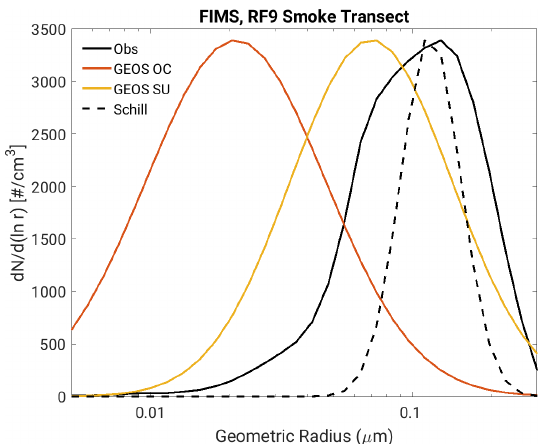
Figure 14. The observed dry aerosol size distribution from FIMS for the flight segment from RF9 as well as the assumed particle size distributions for organic carbon and sulfate in GEOS and the Schill size distribution derived from data collected during SEAC4RS with a median radius of 0.1175µm and sigma of 1.3 (see the Supplement for additional